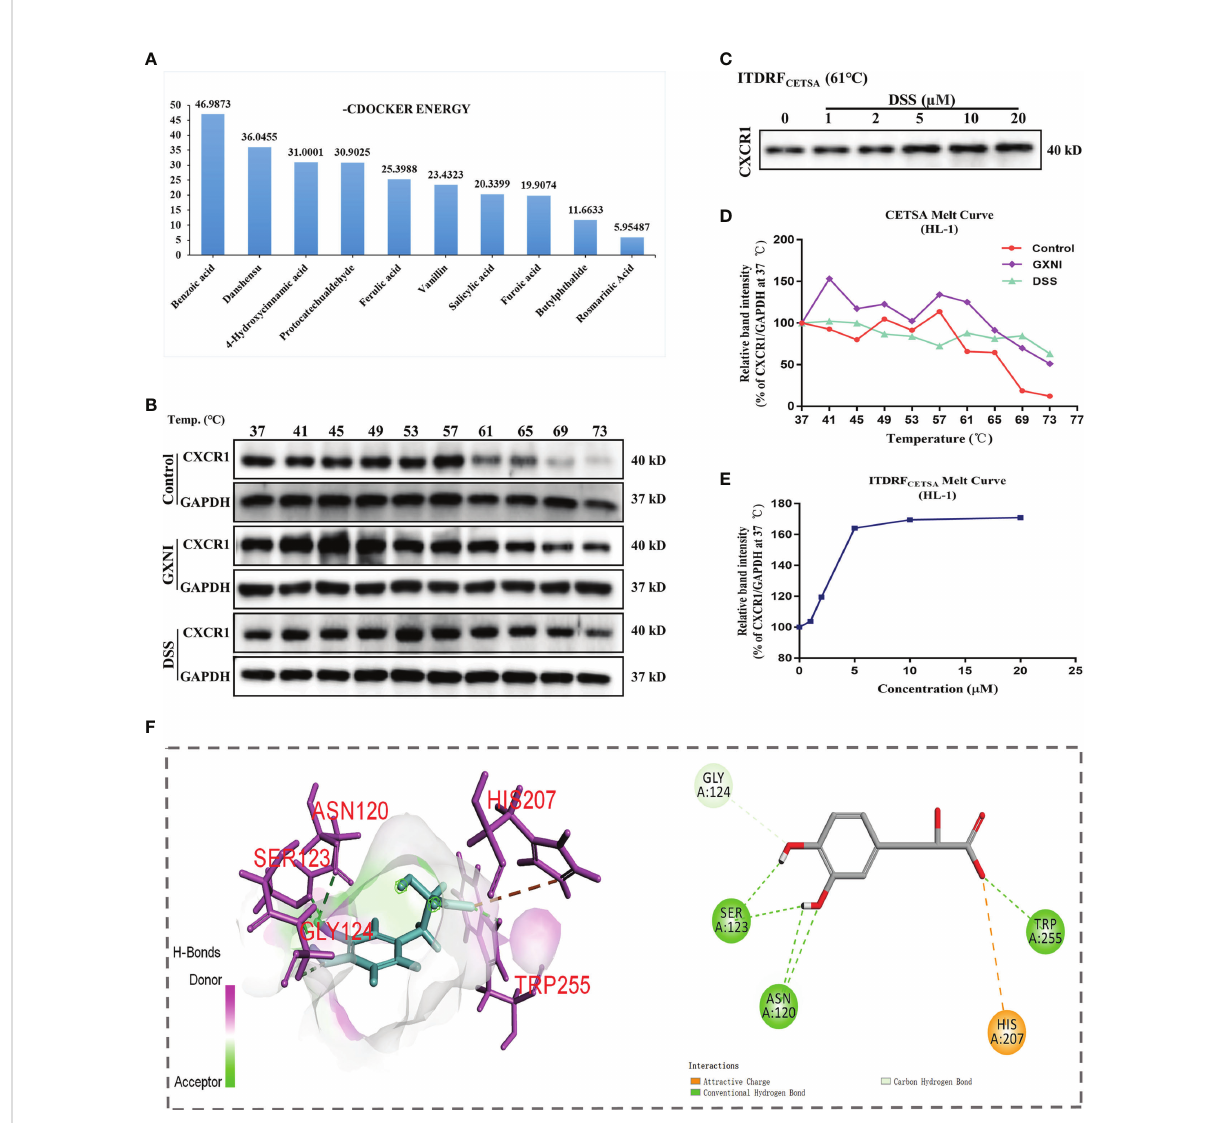
FIGURE 5 Ingredients in GXNI that bind to CXCR1. Structural-based binding prediction of GXNI ingredients to CXCR1 by molecular docking. (A) The score of -CDOCKER ENERGY of ingredients in GXNI combined with CXCRI. CETSA and ITDRF CETSA were utilized to assess the binding between GXNI or DSS and CXCR1 in thermodynamic levels. (B, C) WB blots of CETSA and ITDRF CETSA . (D, E) The curve of CETSA and ITDRF CETSA . (F) Danshensu-CXCRI interaction is depicted by active binding site (3D & 2D